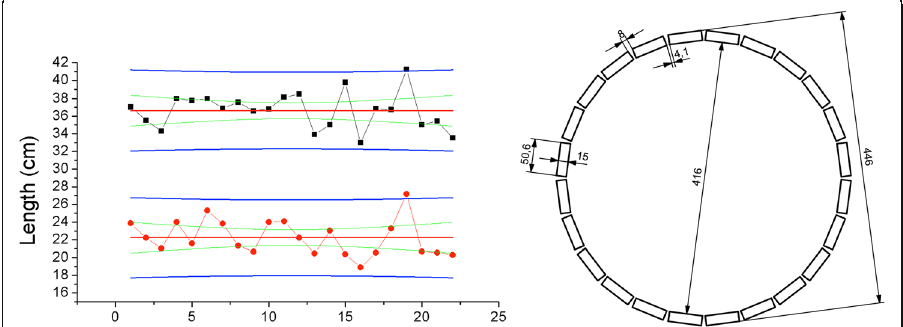
Fig. 1 Left, study on patient dimensions. Black squares represent the “ wide ” measurements, whereas the red circles are the patient thickness. Right, prostate PET ring dimensions (in